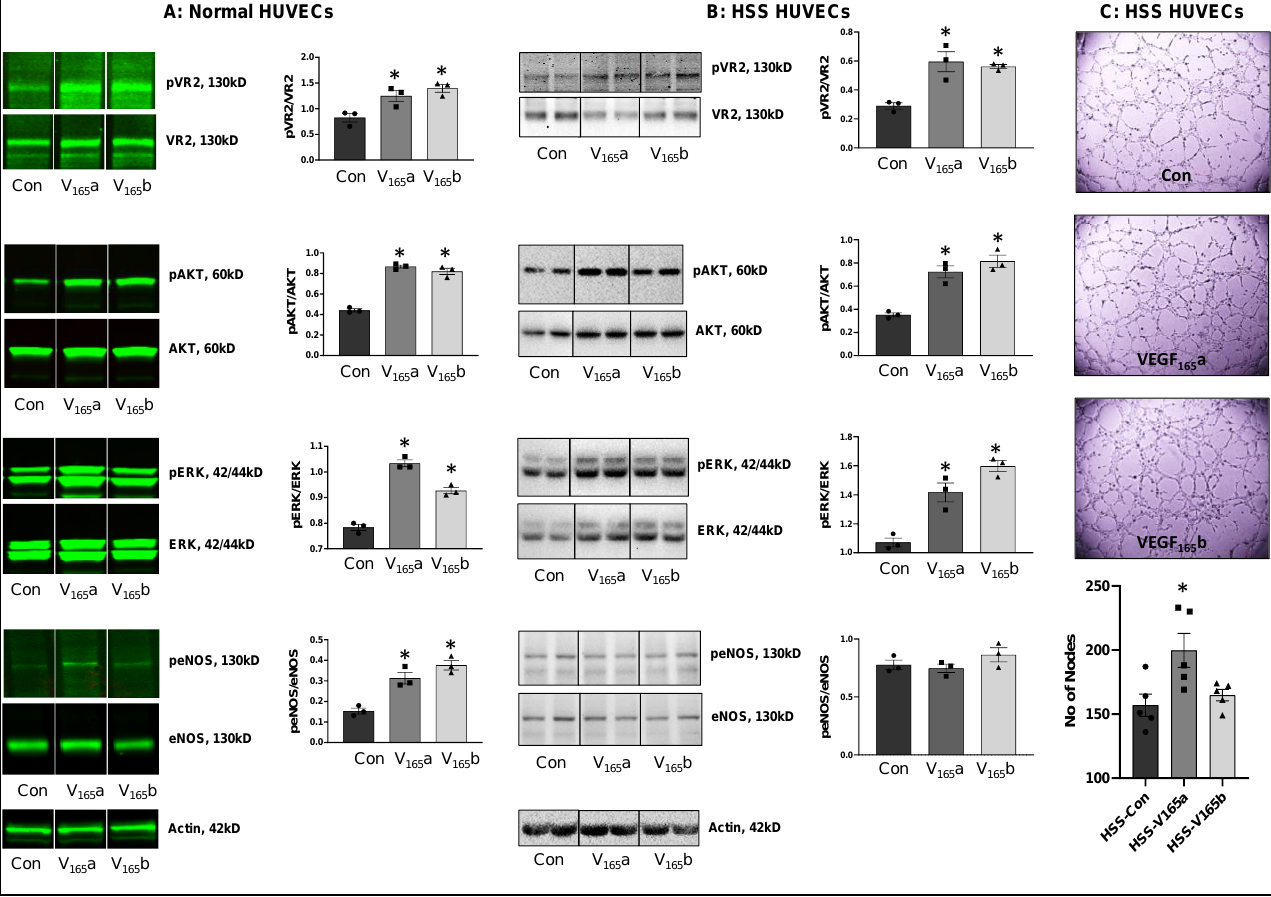
Figure 1. VEGF 165 b activates VEGFR2 signaling in normal and HSS-HUVECs: Immunoblot analysis of pVR2(Y1175)/VR2, pAKT/AKT, pERK/ERK, peNOS/eNOS in ( A ) HUVECs treated with VEGF 165 a (V 165 a, 50 ng/mL) or VEGF 165 b (V 165 b, 50 ng/mL) for 15 min under normal growth conditions, ( B ) HUVECs challenged with HSS for 24 h followed by treatment with V 165 a (50 ng/mL), V 165 b (50 ng/mL) or a combination of V 165 a (50 ng/mL) + V 165 b (50 ng/mL) for 15 min. n = 3. One-way ANOVA with Dunnett’s post -test. * p < 0.05 considered significant. ( C ) In vitro tube formation assay of HSS HUVECs treated with 50 ng/mL of V 165 a or V 165 b for 24 h. n = 5. One- way ANOVA with Dunnett’s post-test. * p < 0.05 considered significant. Data Mean ± SEM.